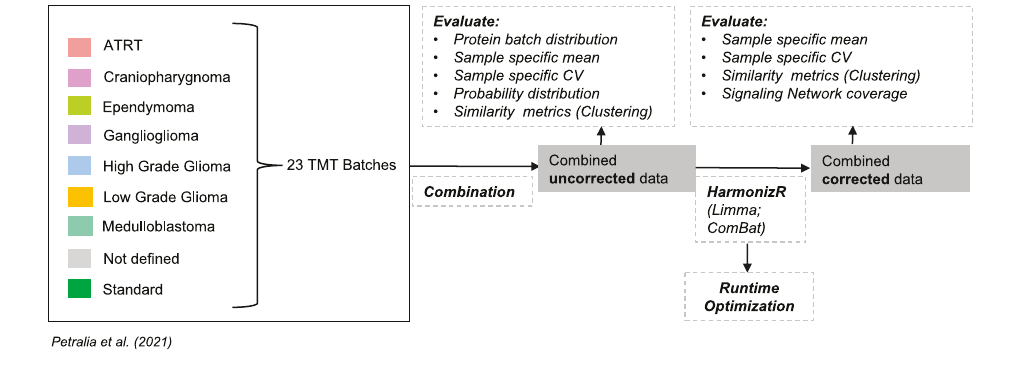
cells and untreated controls were measured using spike-in stable isotope labeling by amino acids in cell culture (spike-in SILAC); Tandem Mass Tag (TMT) and DDA -based Label Free Quanti fi cation (LFQ), respectively, on a Quadrupole — Orbitrap Hybrid mass spectrometer (QExactive, Thermo Fisher Scienti fi c). The dataset can be accessed via the PRIDE archive (PXD014565). The usability of HarmonizR for bigger datasets, including multi-threaded runtime optimization, was tested on a dataset measured by Petralia et al. in 2021 23 . Concisely seven different brain tumor entities were distributed over twenty-three TMT 10-plex batches and measured using a Orbitrap-Iontrap-Quadrupol Tribrid